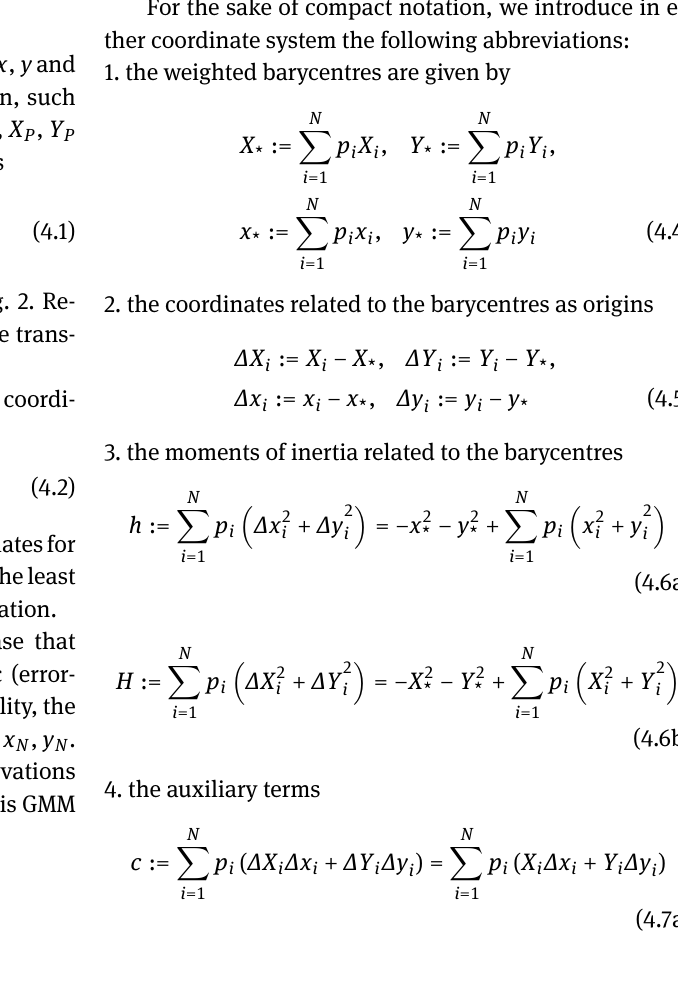
Figure 2: Planar parameter transformation